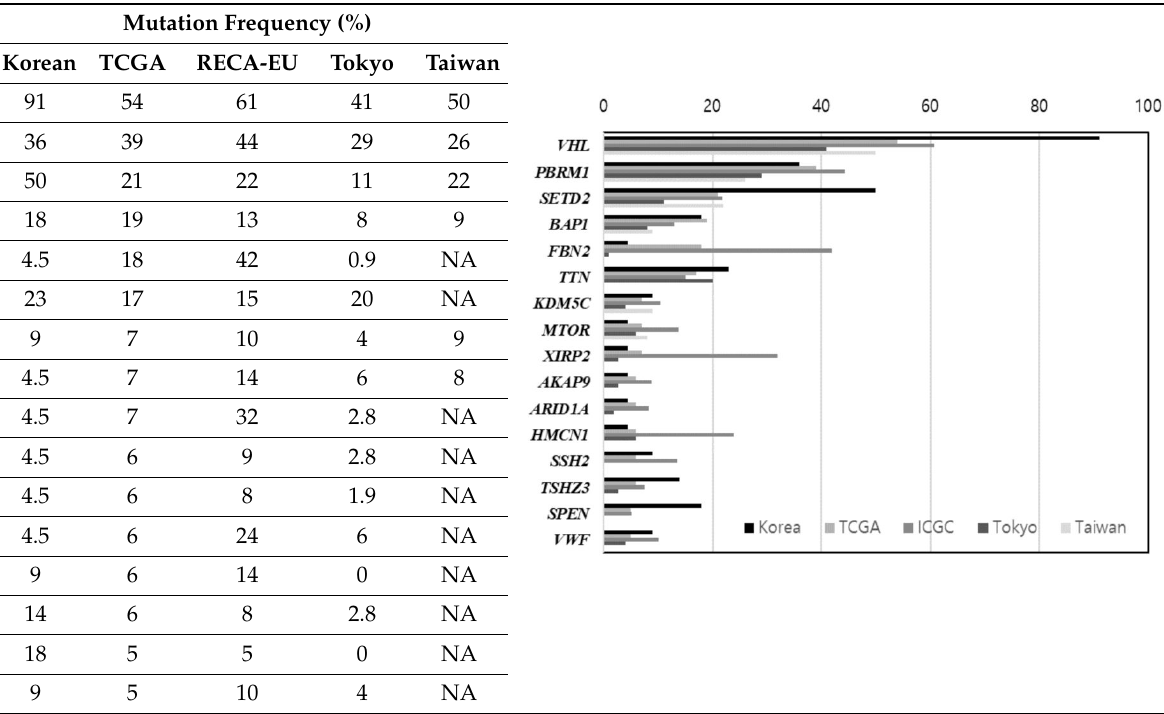
Table 2. Comparison of top-ranked mutated genes in clear cell renal cell carcinoma in 22 Korean patients and patients from other